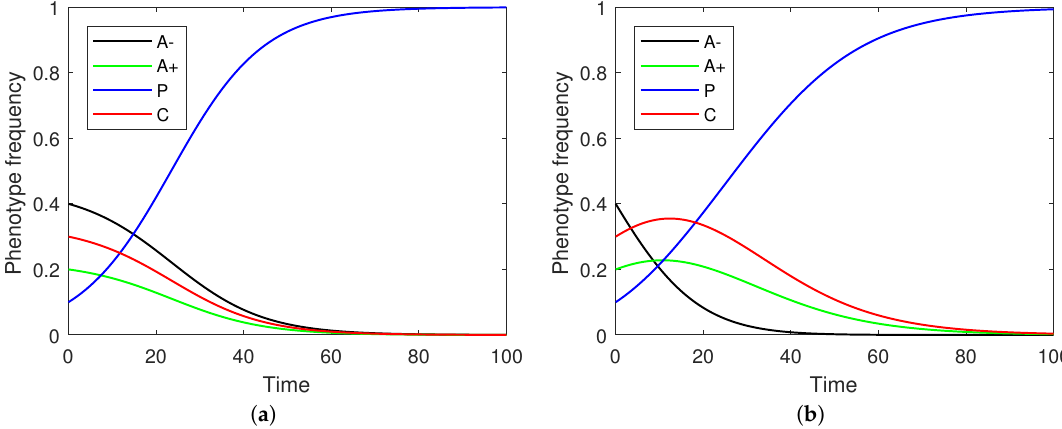
Figure 2. ( a ) Replicator dynamics in discrete time where proliferative cell dominates other strategies. Parameters: a , b , c , d , e , f , g = 0.1; ( b ) Replicator dynamics in continuous time where proliferative cell dominates other strategies. Parameters: a = 0.02, b = 0.02, c = 0.11, d = 0.1, e = 0.1, f = 0.1, g =